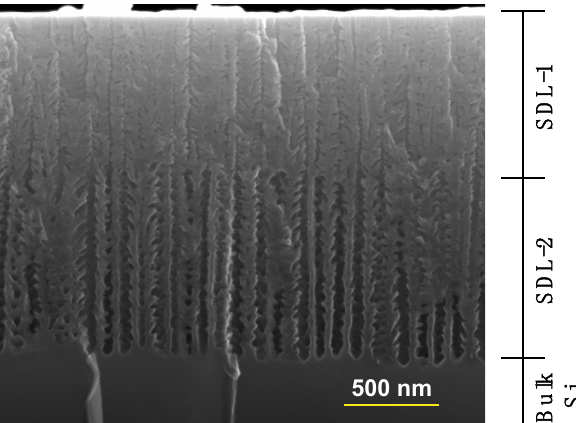
Figure 2. Cross-section SEM image of the sacrificial double layer (SDL) formed by the ENL process, before its dissolution. The first (SDL-1) and second (SDL-2) layers are identified by the description on the right side of the image.